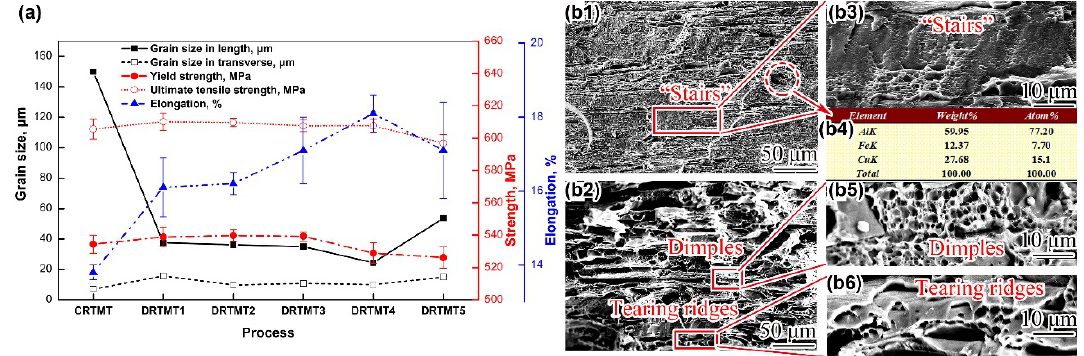
Figure 4. ( a ): Grain size, strength and elongation of CRTMT and DRTMT after T6 aging; ( b ): Tensile fractures of CRTMT ( b1 ) and DRTMT 4 ( b2 ) and the localized morphologies ( b3 and b 4 (EDS result) for CRTMT, b5 and b6 for DRTMT 4 ).